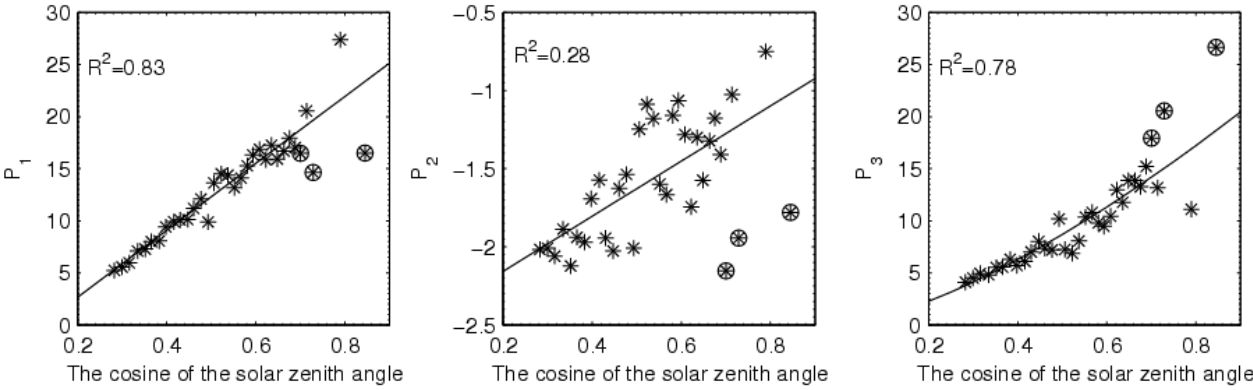
Fig. 4. Scatter plots of the parameters of the exponential equation as a function of the cosine of the solar zenith angle. The black lines represent the fitting results using a linear equation (left, middle) and a power-law equation